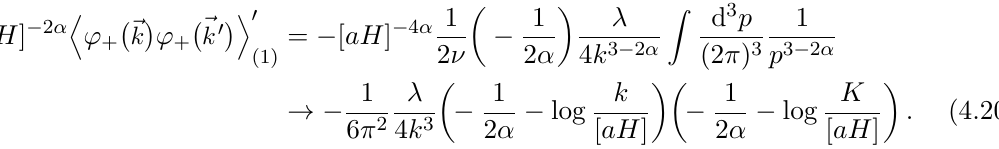
on which our in-in correlators are evaluated. 0